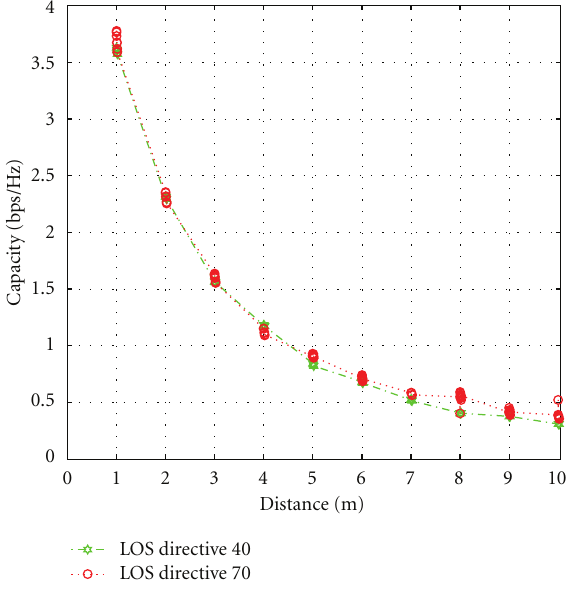
Figure 10: E ff ect of mine corridor size (or physical geometry) on channel capacity.